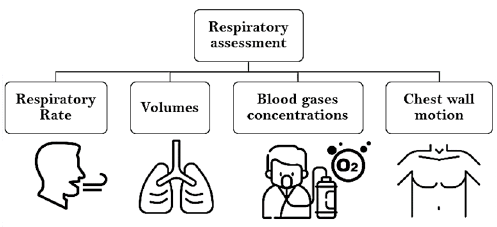
Figure 1. Respiratory parameters classification.